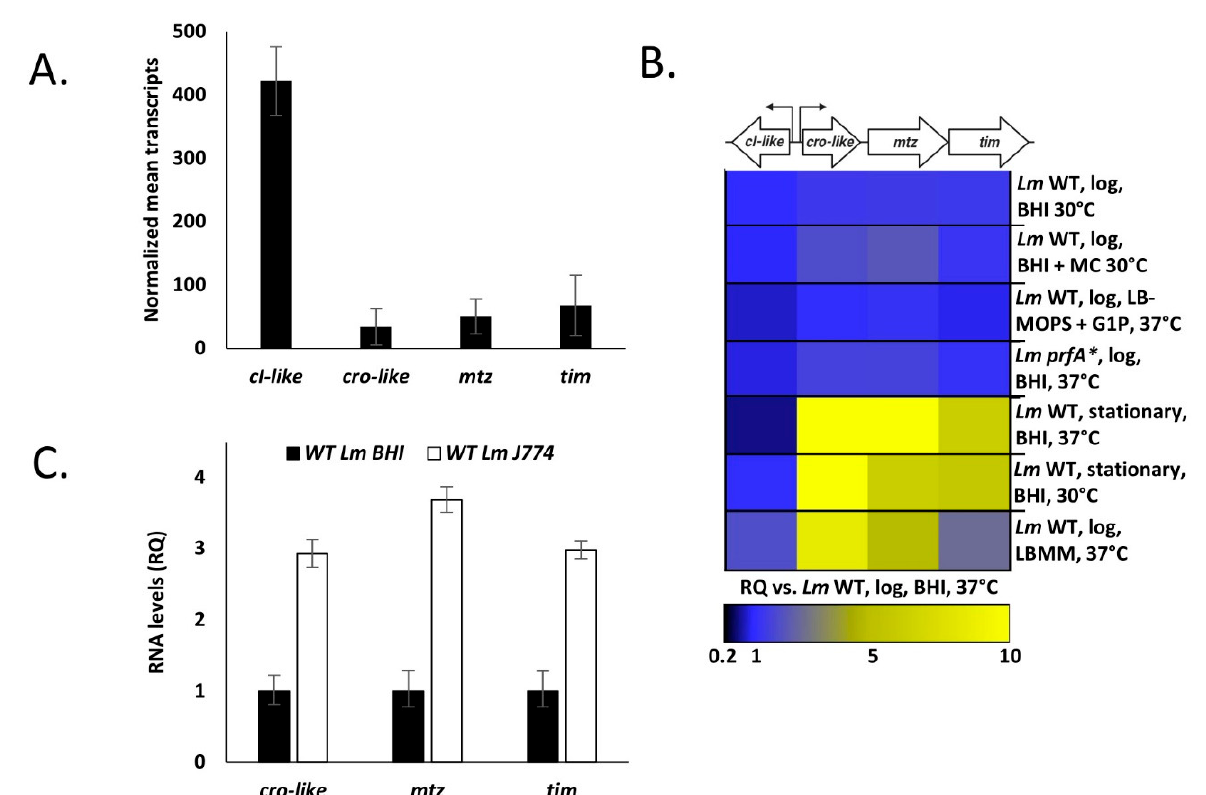
Figure 3. A cro-like, mtz and tim expression is induced during the stationary phase of growth and during growth in intracellular or intracellular-like conditions. ( A ) Quantitative analysis of the transcription level of the cl-cro-like locus of WT Lm grown to mid-log phase in BHI at 37 °C. Transcriptional levels are normalized to the transcription level of the rpoD gene. The data represent the mean of three independent experiments. Error bars indicate standard deviation. ( B ) Transcriptional analysis of the cIcro-like locus in WT Lm grown in different conditions, and of prfA* mutant strain. RT-qPCR data are presented as relative quantity (RQ), compared to the mRNA levels in WT bacteria grown to mid-log phase in BHI at 37 °C and normalized to the levels of the rpoD gene. The data are presented as a heat map and incorporate three independent experiments. ( C ) RT-qPCR transcriptional analysis of the cI-cro-like locus of WT Lm grown in J774 cells for 6 h. Data are presented as relative quantity (RQ), compared to the levels in WT bacteria and normalized to the levels of the rpoD gene. The data represent two independent experiments. Error bars indicate the 95% confidence interval.